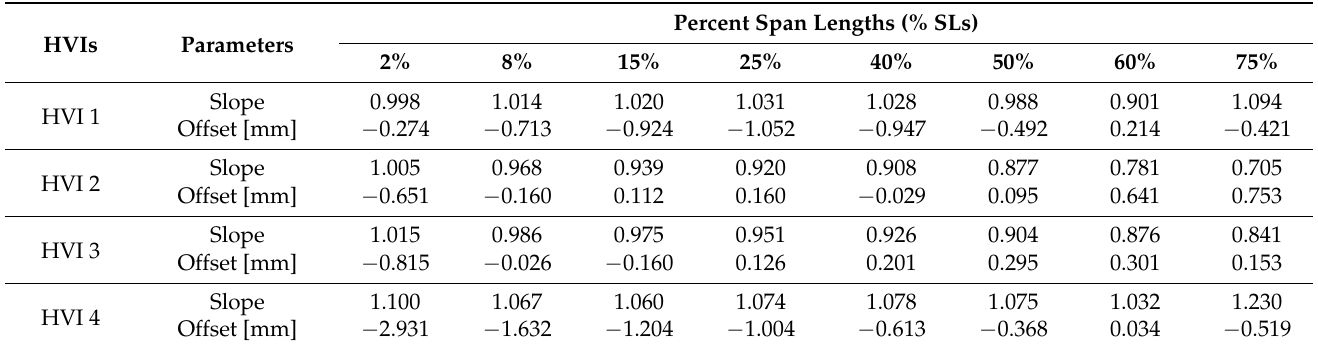
Table 2. Linear correction parameters for length data extracted from the reference cotton fibrograms.